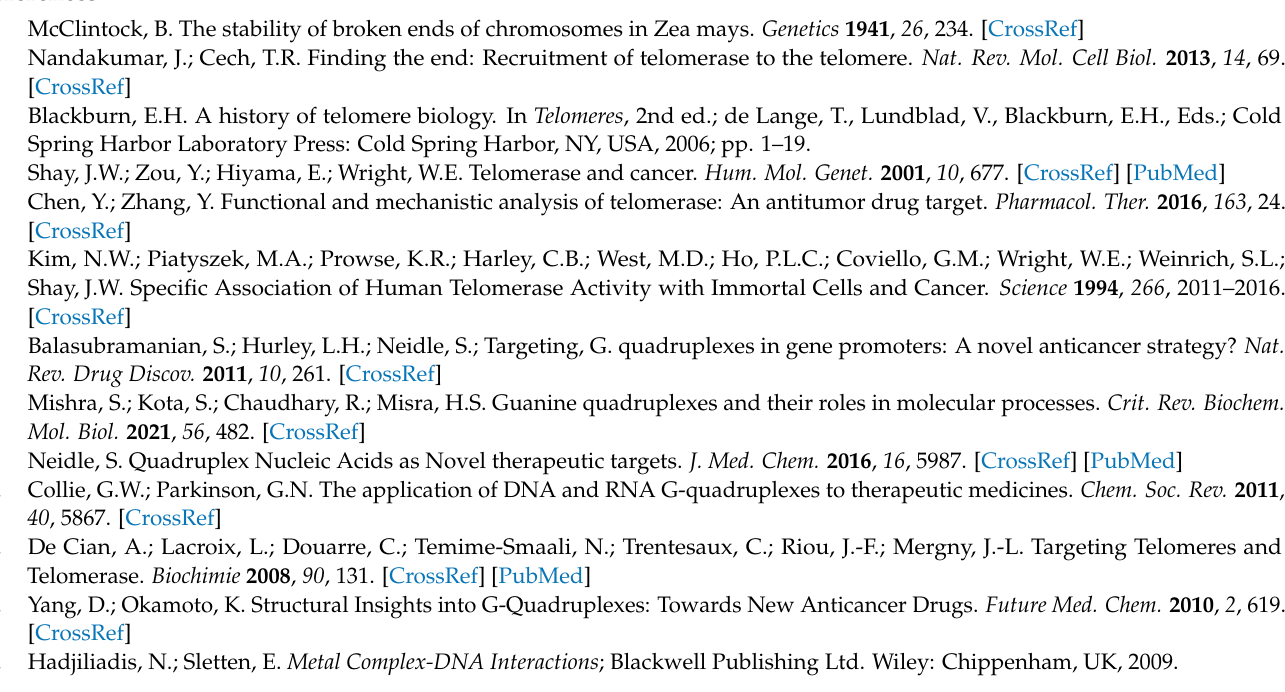
parameters, Figure S1: UV-Vis spectra obtained from titration of Ag II TMPyP with the tetramolecular GQ DNA structure TG 4 T, Figure S2: UV-Vis spectra obtained from titration of Ag II TMPyP with the bimolecular GQ DNA structure G 4 T 4 G 4 , Figure S3: UV-Vis spectra obtained from titration of Ag II TMPyP with the unimolecular GQ DNA structure AG 3 (T 2 AG 3 ) 3 , Figure S4: UV-Vis spectra obtained from titration of AgIITMPyP with the double-stranded DNA structures from salmon sperm, Figure S5: Mass spectrum of the Ag II TMPyP derivative, Figure S6: Comparative UV-Vis absorption spectra (350–650 nm) at the end of titration (1:3 L:DNA) of the solution of (A) Ag II TMPyP, (B) H 2 TMPyP, (C) Zn II TMPyP, (D) Co III TMPyP (E) Ni II TMPyP, (F) Pd II TMPyP, (G) Cu II TMPyP and (H) Mn II TMPyP (2.0 µ M) with the selected unimolecular, bimolecular and tetramolecular GQ structures and salmon sperm double-stranded